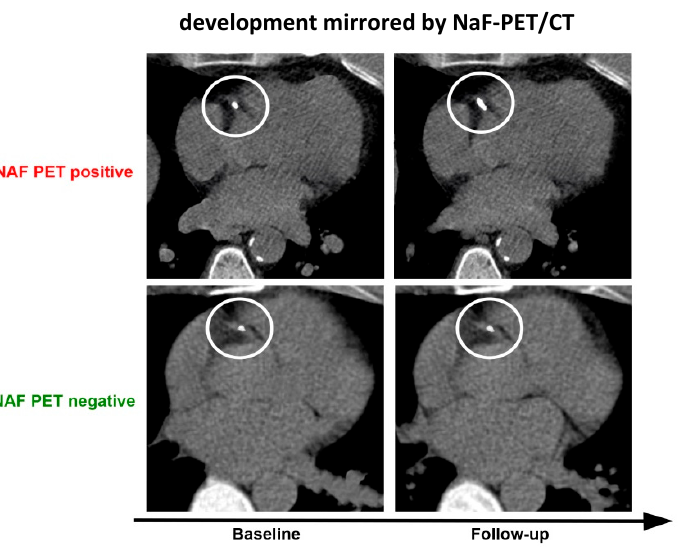
Figure 3. The recent ‘microcalcification-based’ perception of atherosclerosis development. Instead of showing inflammation, as FDG PET/CT is supposed to do, within the circles, this fabricated figure illustrates ( upper panel ) that a small, but NaF-avid (not shown directly) CT-detectable lesion in the proximal part of the right coronary artery has grown in size at follow-up after some years, at which point it has become more dense and less NaF avid due to a decrease in surface area. In contrast, ( lower panel ) a NaF-negative CT-visible lesion will usually not develop further. It remains unclear what the precise context for this phenomenon is; for details, see [52–54].